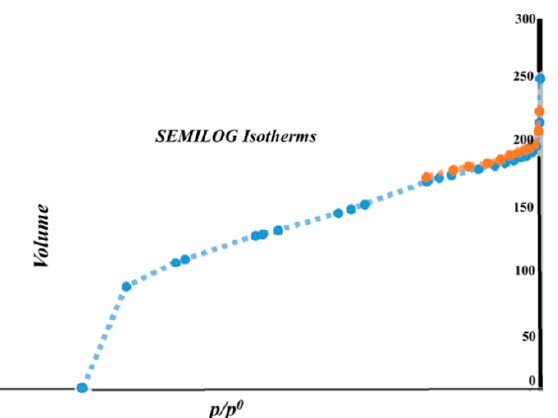
Figure 2. The adsorption–desorption isotherms of N 2 at 77 K of